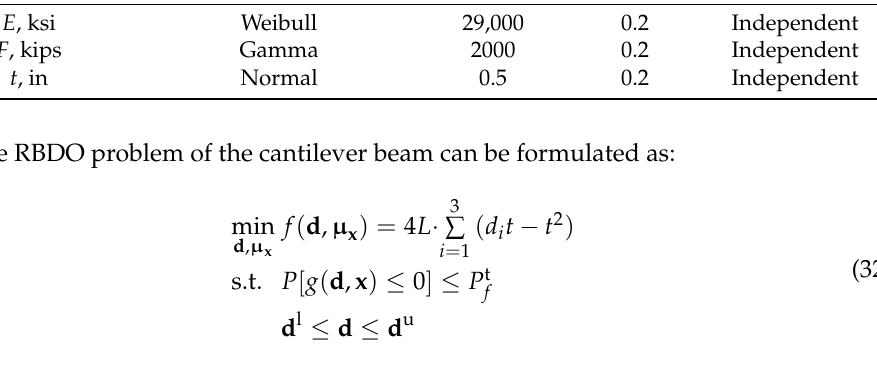
Table 8. Results obtained using the RBDO/CS – SORM/SORM-i for the cantilever beam. RBDO method